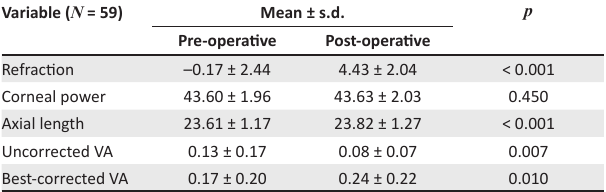
TABLE 2: Pre-operative and post-operative comparison of variables.